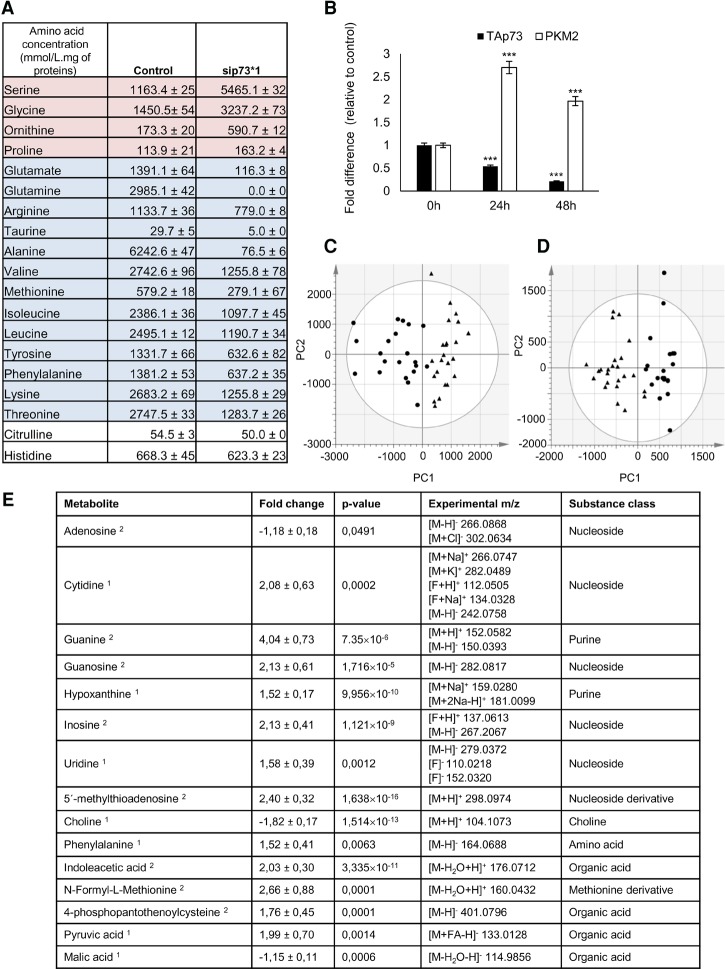
p73 regulates metabolic pathways in MB. DAOY cells were transfected with scramble or sip73*1 (ID 2671). (A) After 48 h, the medium was collected, and amino acid levels were quantified. n = 3. (B) After 0, 24, and 48 h, cells were collected, and RT–PCR was performed for TAp73α and PKM2 genes. Columns indicate mean ± SEM. n = 3. (***) P < 0.0001. (C,D) Liquid chromatography hyphenated to high-resolution mass spectrometry (LC-HRMS) metabolic profiling of DAOY scramble (●) and sip73*1 cells (▴). PCA score plots of the first two components: PC1 and PC2. The data were normalized to median fold change and pareto scale. (C) Positive ionization mode (R2X = 0.602 and Q2 = 0.137). (D) Negative ionization mode (R2X = 0.761 and Q2 = 0.355). (E) List of the affected metabolites after p73KD in DAOY cells. (Note 1) Confidently identified metabolites; identification was based on retention time, exact mass, and fragmentation as compared with an analytical standard that was analyzed under the same conditions. (Note 2) Putatively annotated metabolites; annotation was based on exact mass and fragmentation as compared with available reference spectra.